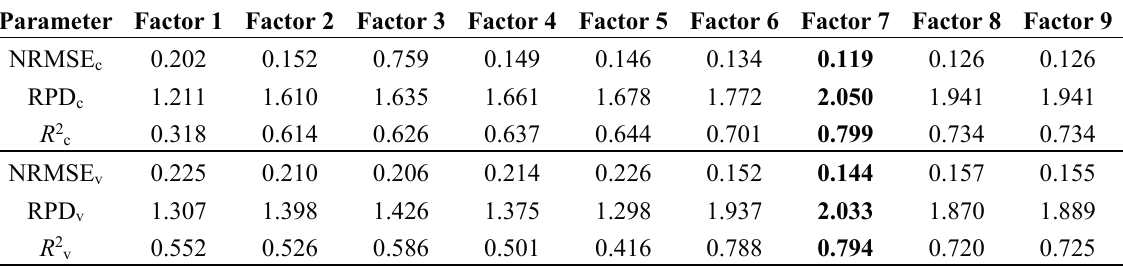
Table 5. Evaluation criteria for PLSR